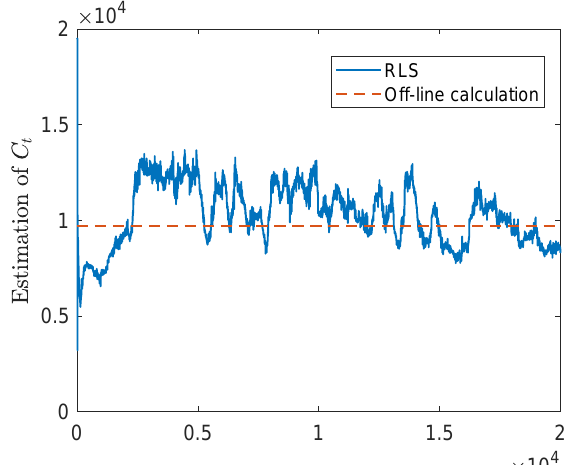
Figure 8. Comparison of the estimated results of C t